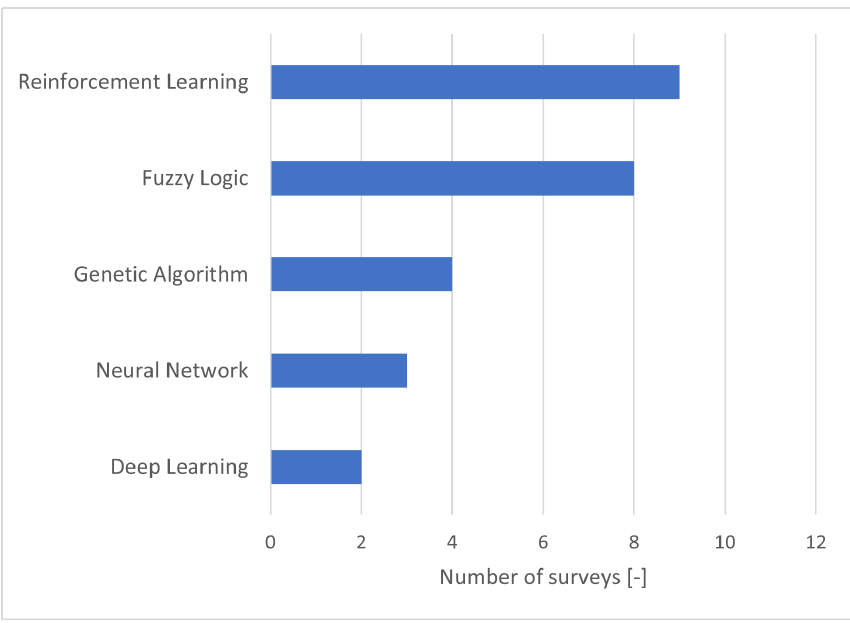
Figure 7. Artificial intelligence methods validated in numerical